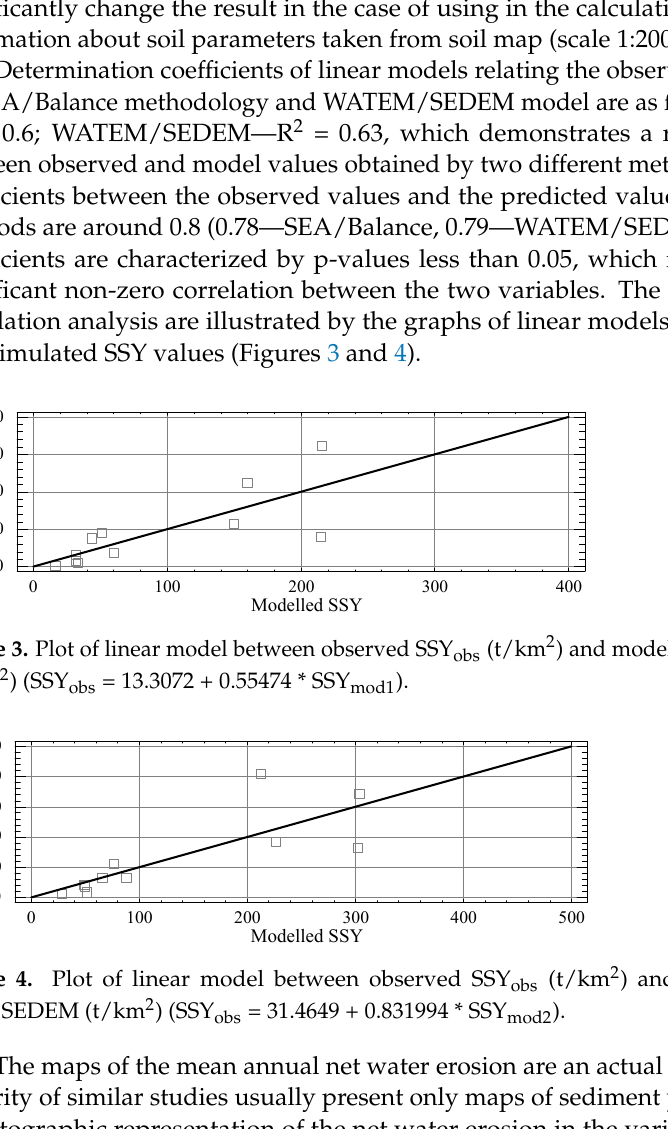
Figure 5. Map of the net water erosion obtained using WATEM/SEDEM methodology for Nur- minka river basin (Numbers: 1—river basin boundary, 2—settlements, 3—water bodies, 4—SSY observation station, 5—roads, 6—rivers, 7—railroads, 8—sediment accumulation places within dry valleys and terrace joints).